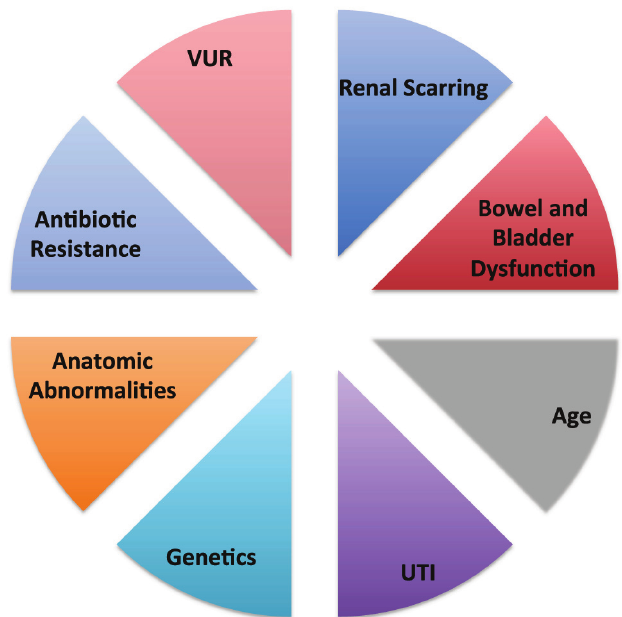
Figure 1. Pie graph representing risk factors for acute pyelonephritis. As shown, vesicoureteral reflux (VUR) is one of several important risk factors illustrating the multifactorial nature of urinary tract infection (UTI)/VUR management. Individual factors may or may not be present in an individual patient and play varying roles in UTI recurrence and VUR resolution and